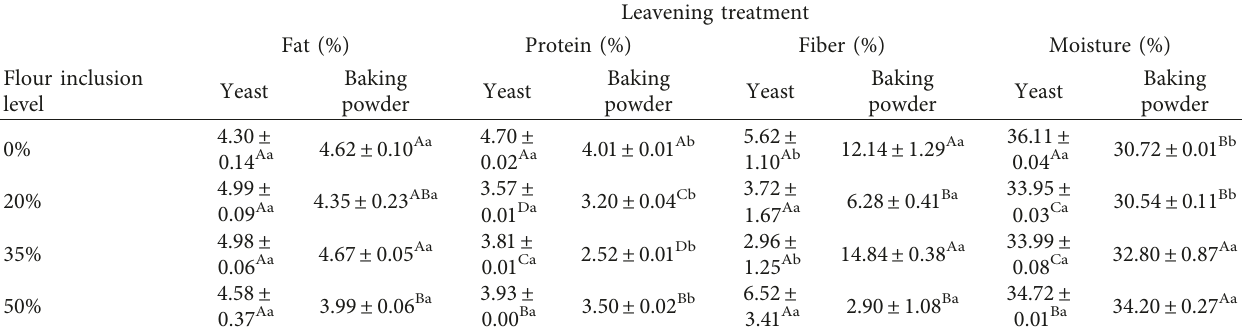
Table 5: Mean proximate analysis values of experimental gluten-free bread